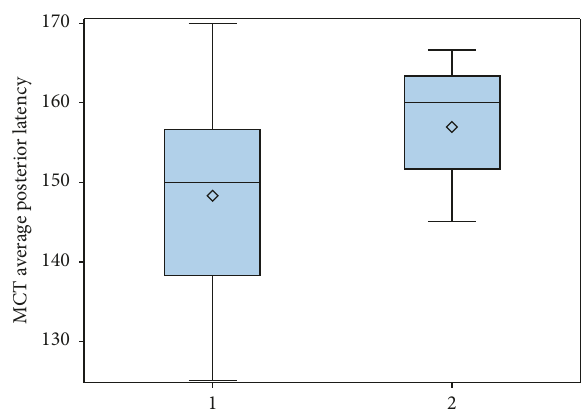
Figure 6: Comparative boxplot of motor control test posterior latency performance of Parkinson’s disease cohort based on the PD subtype. Subtype 3 was not included in this analysis as it is an intermediate group with symptoms specific to both subtypes 1 and 2. MCT, motor control test. 1: tremor dominant. 2: postural in- stability and gait